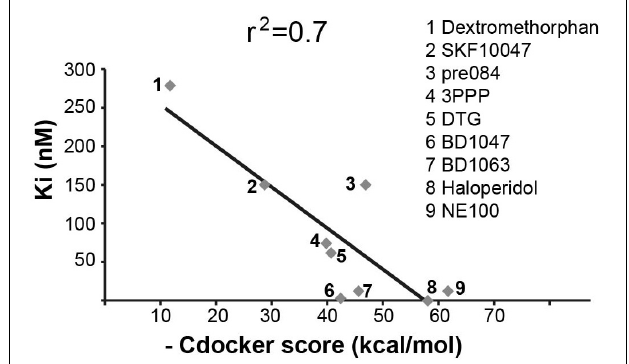
FIGURE 3 | Correlation between experimentally determined Ki values and calculated docking scores. Correlation ( r 2 = 0.7) between known Ki values and CDOCKER scores (kcal/mol) for known S1R binders, as indicated. Higher CDOCKER values correspond to better binding energies.